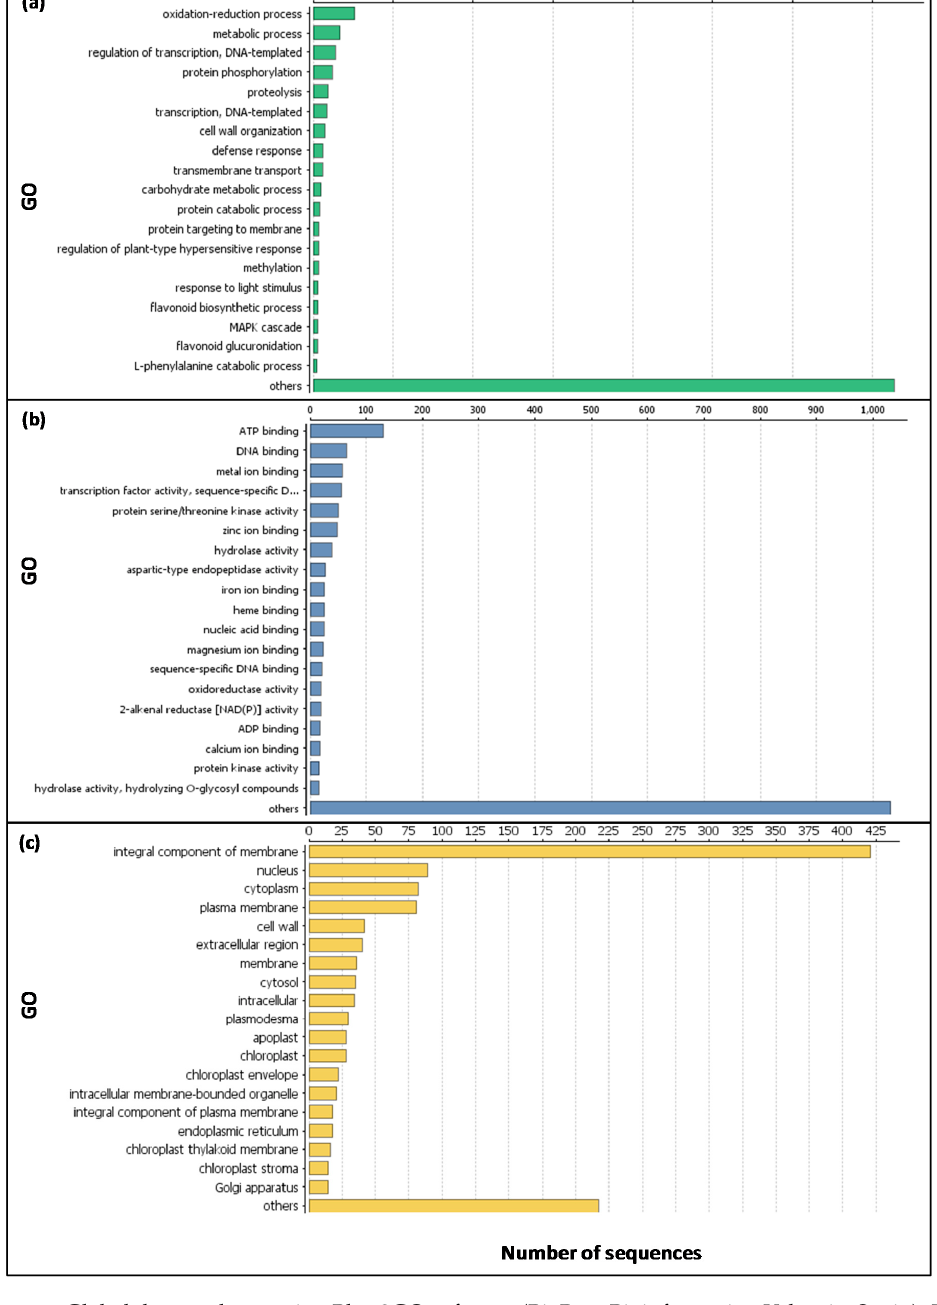
Figure 9. Global data analyses using Blast2GO software (BioBam Bioinformatics, Valencia, Spain). The X-axis indicates the number of transcripts in a sub-category and the Y-axis indicates the sub-category. ( a ) Biological process; ( b ) molecular function and ( c ) cellular component GO terms.